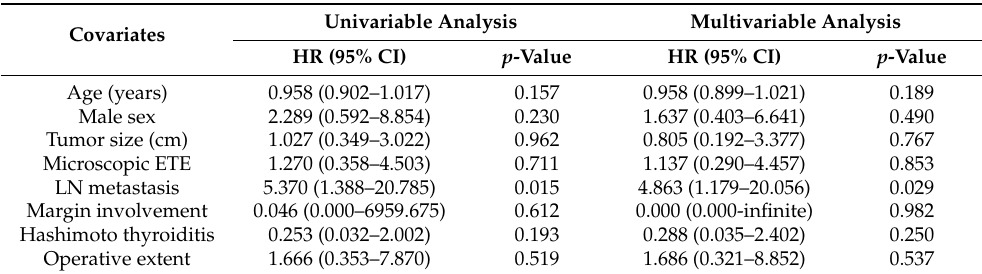
Table 3. Univariable and multivariable analysis for predictive factors of recurrence in patients with multifocal PTCs. Covariates